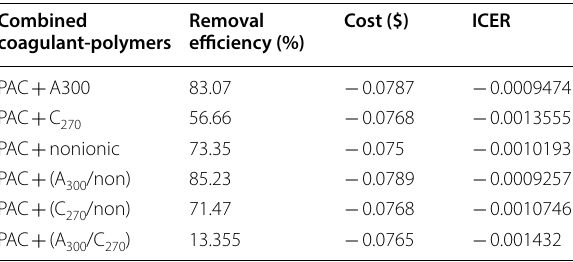
Table 4 ICER estimated for compounds used for ceramic- tile wastewater treatment Combined Removal coagulant-polymers efficiency (%)